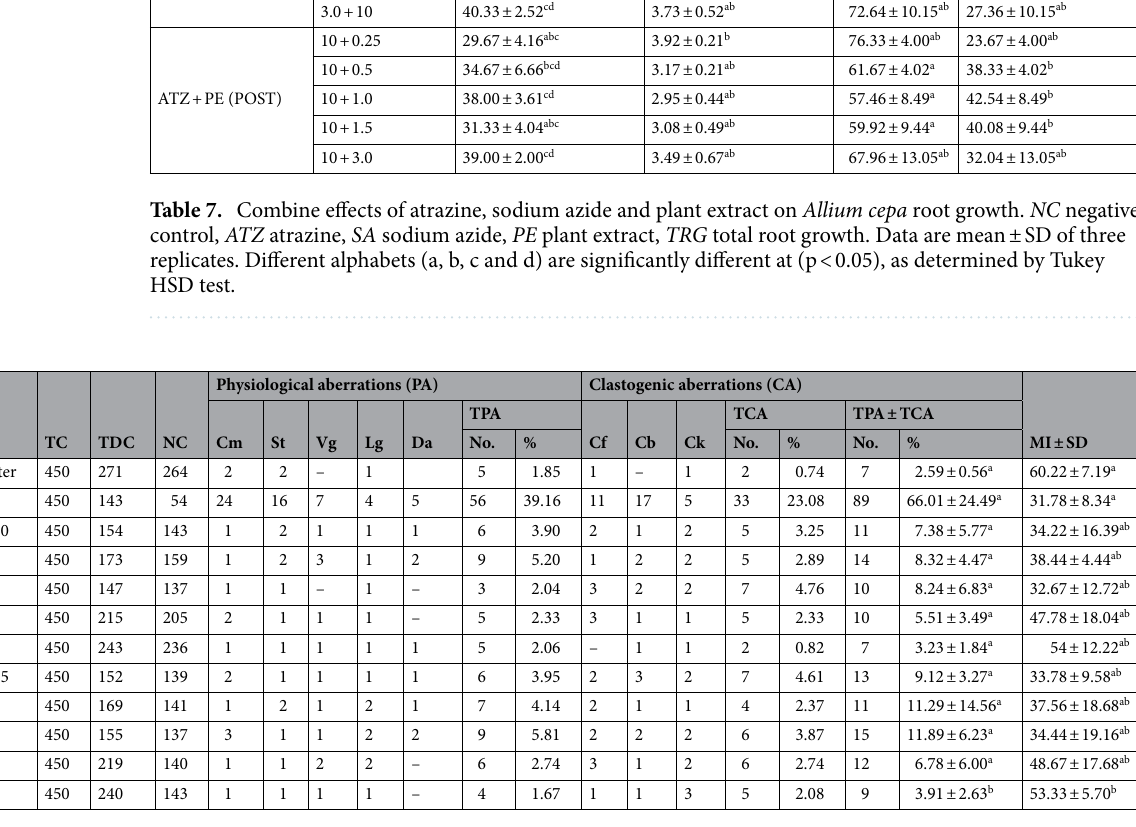
Table 8. Antigenotoxic potential of aqueous extract of leaves of Royale cinerea (D.Don) Baillon by Allium cepa root tip assay with pre- and post-treatment against the genotoxicity induced by atrazine. NC negative control, ATZ atrazine, SA sodium azide, PRE pretreatment, Post posttreatment, TC total cells, TDC total dividing cells, NC normal cells, Cm C-mitosis, St stickiness, Vg vagrant, Lg laggard, Da delayed anaphase, Cf chromosome fragments, Cb chromosome bridge, Ck chromosome break, TPA total physiological aberration, TCA total clastogenic aberrations. Data are mean ± SD of three replicates. Different alphabets (a and b) are significantly different at (p < 0.05), as determined by Tukey HSD